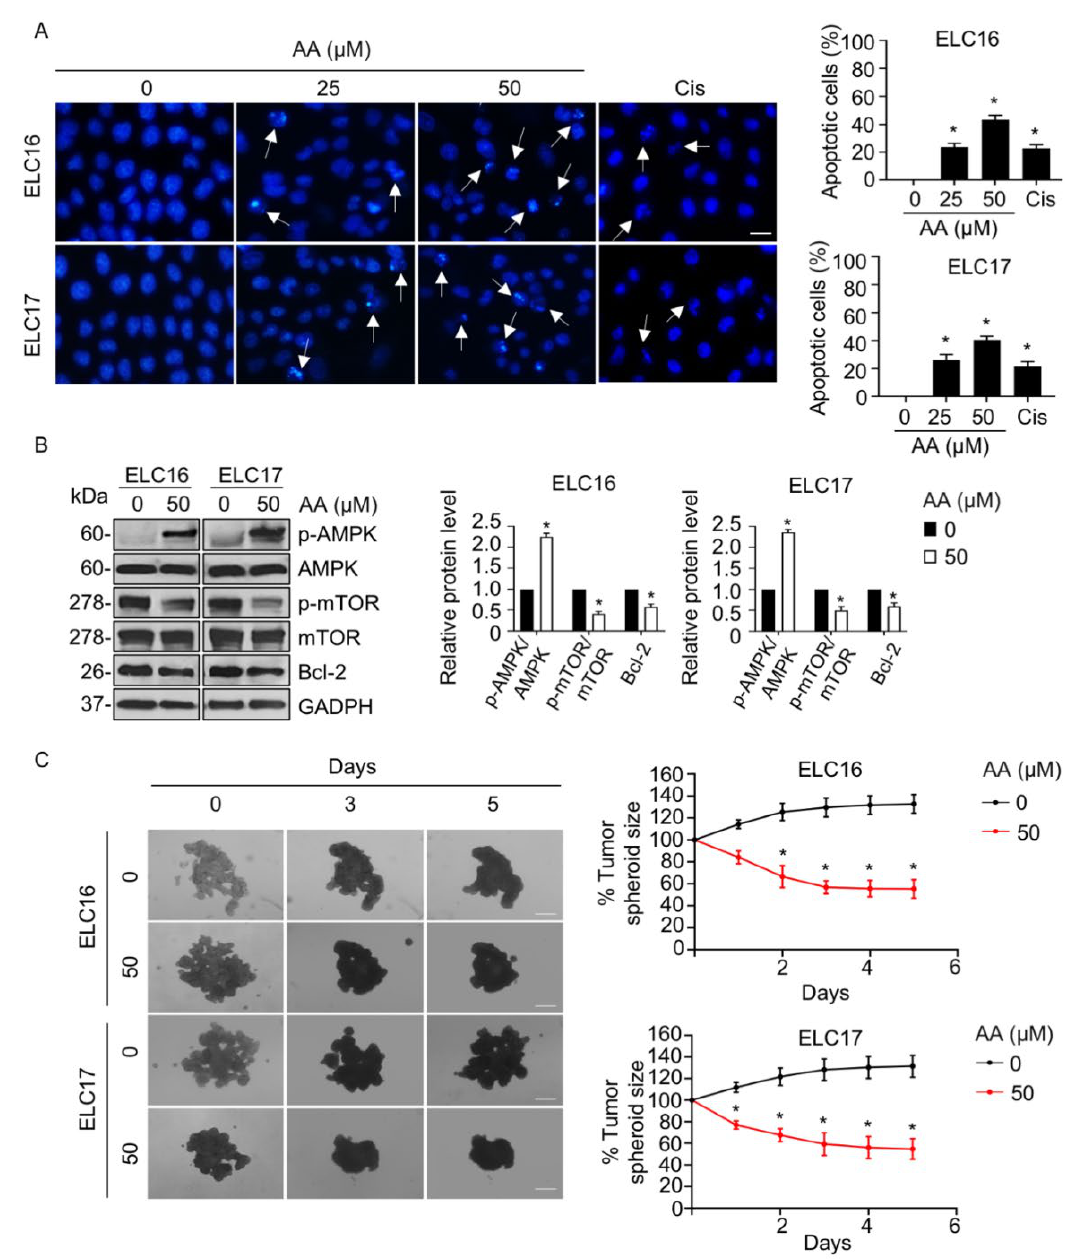
Figure 7. Aspiletrein A (AA) induced patient-derived lung cancer cell apoptosis. ( A ) Patient-derived lung cancer (ELC16 and ELC17) cells were treated with AA (0 − 50 µ M) or cisplatin (50 µ M) for 24 h. Nuclei are blue in which apoptosis nuclei are indicated by the arrow and detected using H33342 staining and imaged with a fluorescence microscope. Apoptotic cells were analyzed from at